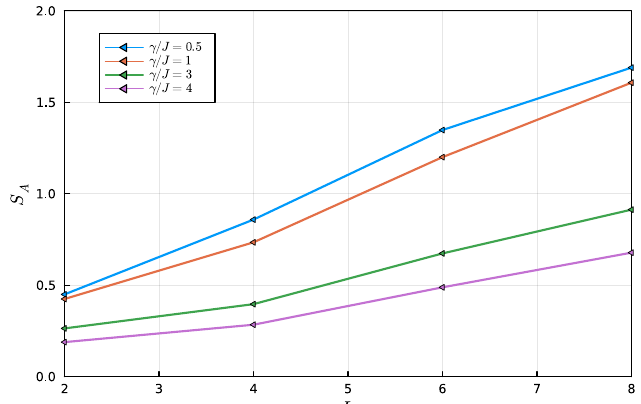
Figure 5: The longtime saturation value of entanglement entropy S of the subsystem A = L / 4, total number of bosons N = L / 2. A with different system size N and fixing L s A b Different curves have different γ in the unit of J . Here, U / J = 1. We choose a set of N = 100 quantum trajectories for L = 8 and N = 1000 quantum trajectories for L = 2,4,6.We choose the initial state as a product state in the particle number basis. We choose the initial state | 01 〉 for L = 2, | 0011 〉 for L = 4, | 000111 〉 for L = 6 and | 00001111 〉 for L =